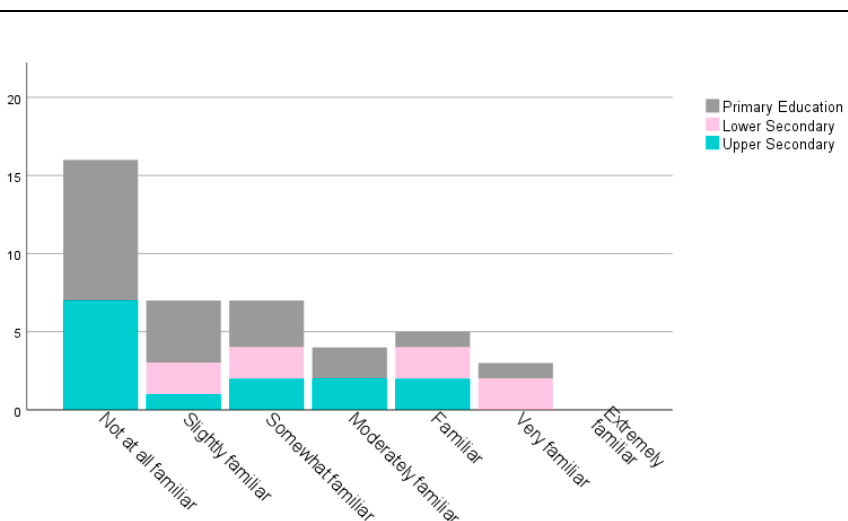
Figure 2. Participants’ familiarity with immersive technologies across the different occupational levels.